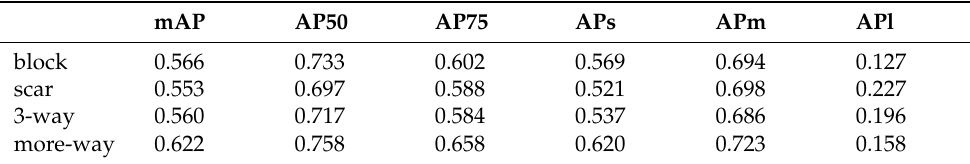
Table 5. Detection accuracy with different CutPaste tasks in SS R-CNN. mAP AP50